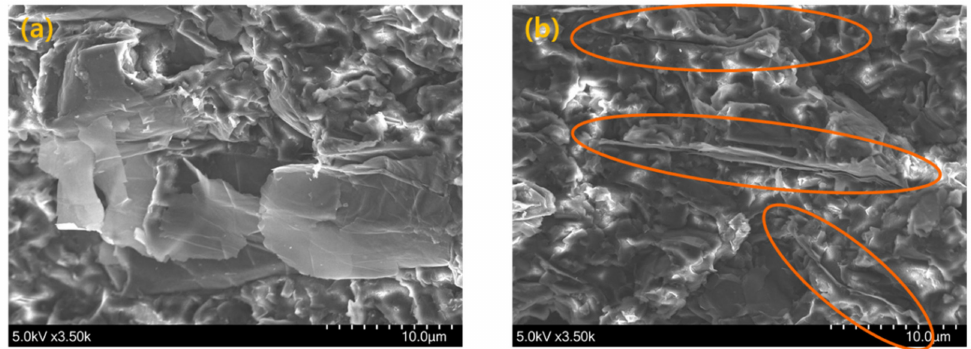
Figure 7. SEM images of ( a ) SAN / rGO (3.0 wt % rGO) and ( b ) SAN–mRGO2 (3.0 wt %